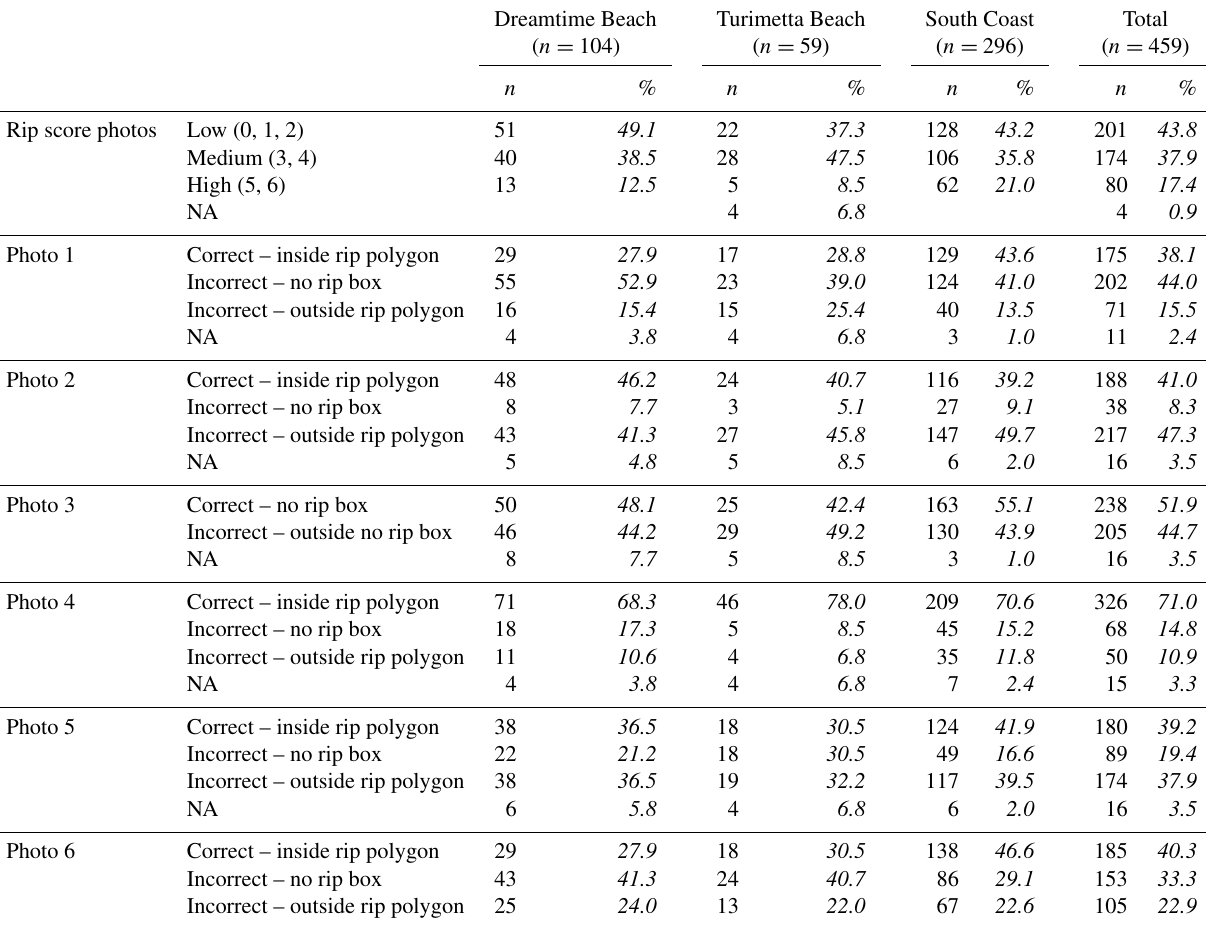
Table 3. Survey respondent rip scores from the images shown in Fig. 6. A “low” score was defined as 0–2 correct answers, “medium” as 3–4, and “high” as 5–6. The bottom half of the table shows if respondents were able to correctly identify the rip current (marked the location inside the rip polygon) or if they believed that there was no rip current (“no rip box”). Photo 3 did not have a rip current and thus beachgoers who ticked the “no rip box” were correct. NA refers to people who did not answer the question. Percentages are shown in